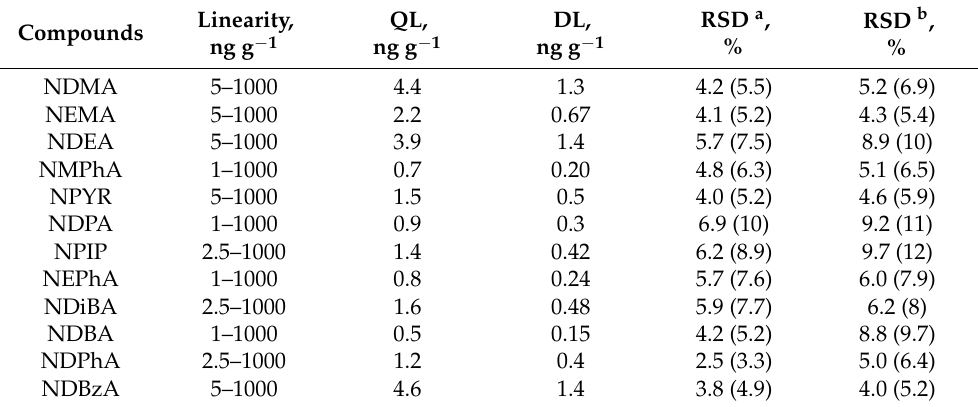
Table 2. Analytical characteristics of the DLLME-GC–MS method for NAs